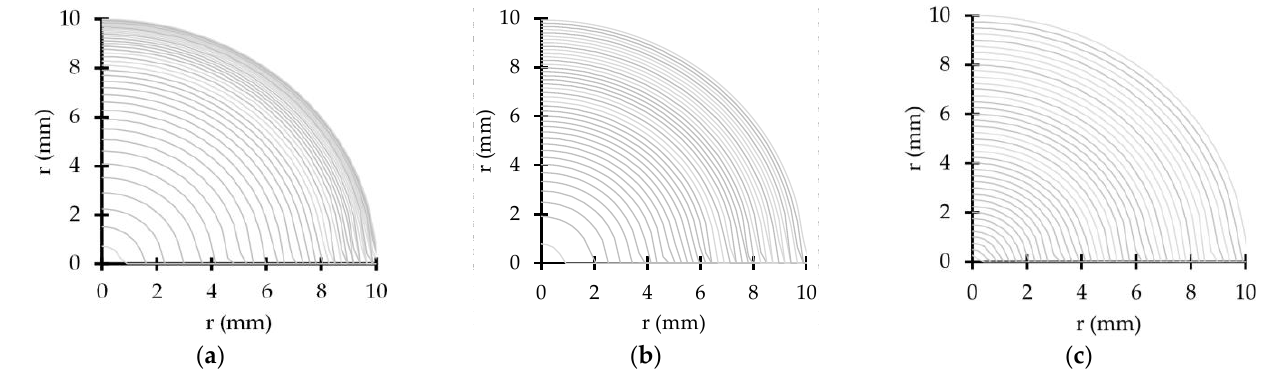
Figure 2. Radial meshes with different geometries for N C = 40: ( a ) GS5%40; ( b ) EAC40; and ( c ) ETC40.